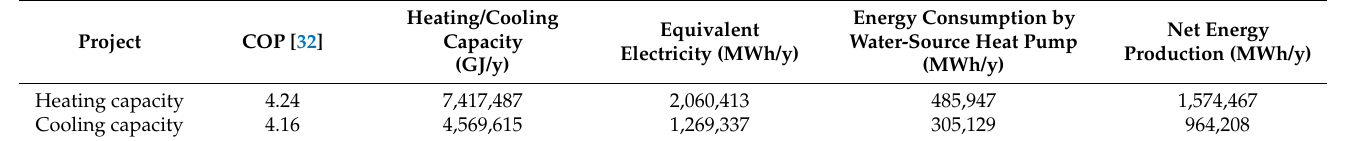
Table 3. Theoretical heating and cooling capacity of the water-source heat pump system in Gaobeid- ian WWTP.